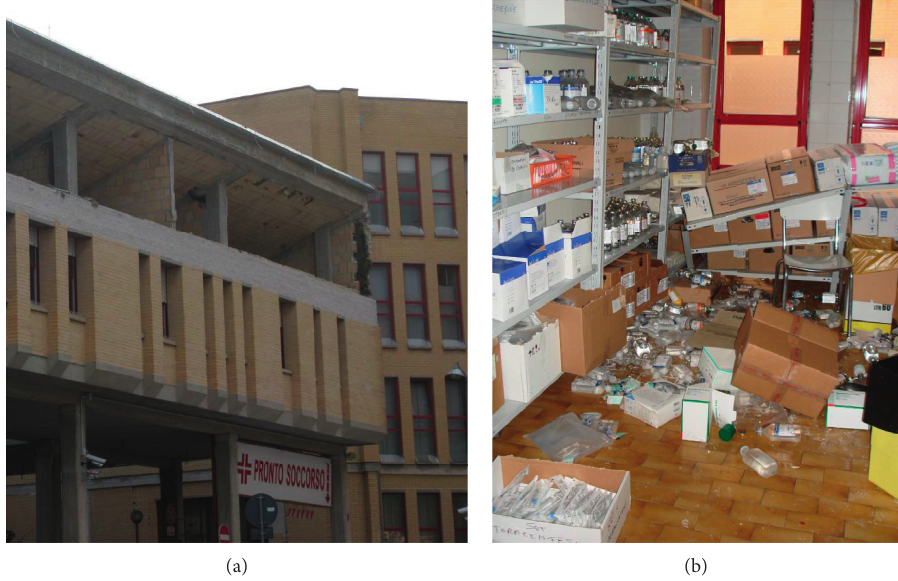
Figure 1: Effect of the L’Aquila earthquake (2009) on the Coppito Hospital: (a) falling off the infills on the entry of an emergency room and (b) overturning of shelves in the hospital